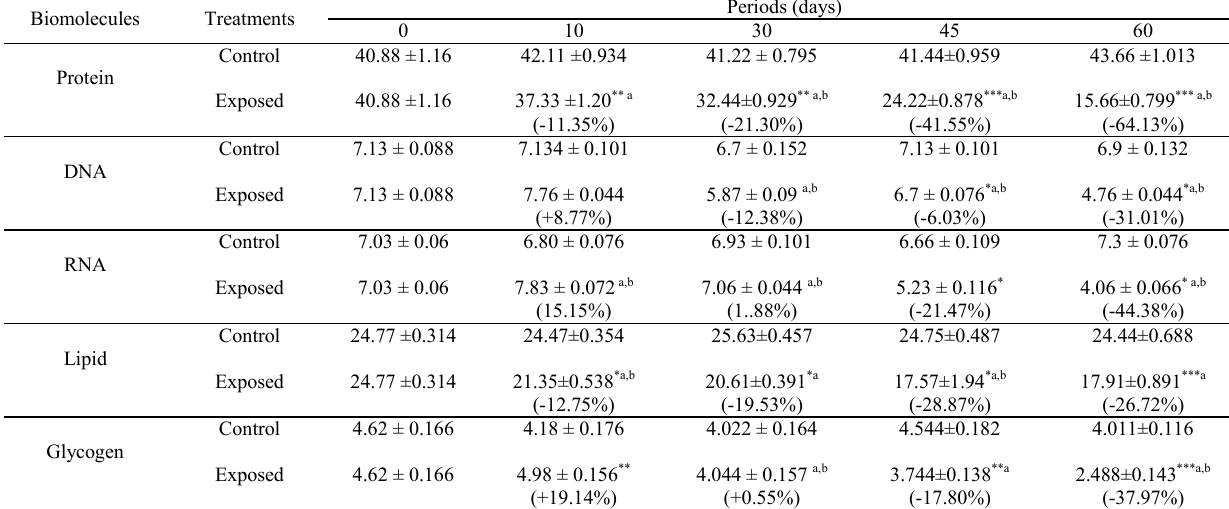
Table 2. Fluctuations in different biomolecules in the gills of Clarias batrachus at different period of exposure to 1 mg/L of sodium arsenite. Protein, DNA, RNA, lipid, and glycogen were expressed in mg/gm wet wt of tissue. Data are shown as mean ± SEM (n = 9). (%) Denote changes over respective controls. Two way ANOVA followed by Dunnett’s t -test. The criterion for significance differences set at ( * ) p <0.05, ( ** ) p <0.01 and ( *** ) p <0.001 with respective control. ( a ) Indicates when exposed groups were compared with 0 day controls and ( b ), when exposed groups were compared with previous exposed group.